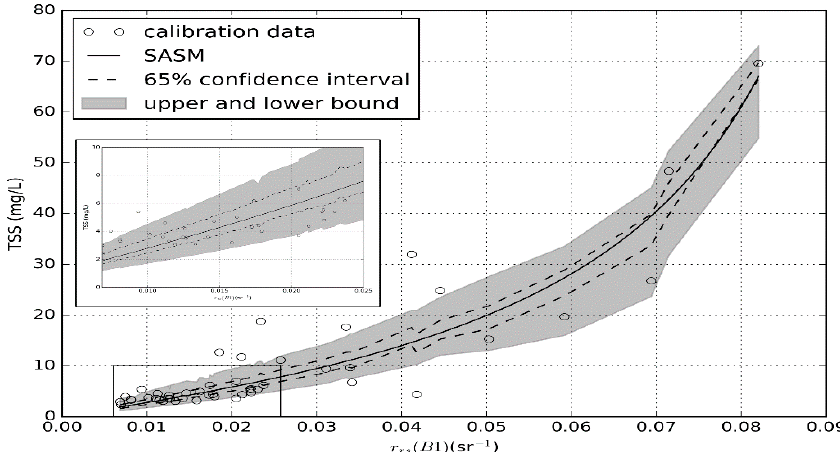
Figure 3. The SASM curve for r rs (B1) (Equation (18)) is shown by the solid line. The in situ data points are shown by open circles. The 65% confidence limits obtained through the bootstrap method are shown by dashed lines. The greyed region represents the upper and lower bound for 1000 bootstrap runs.